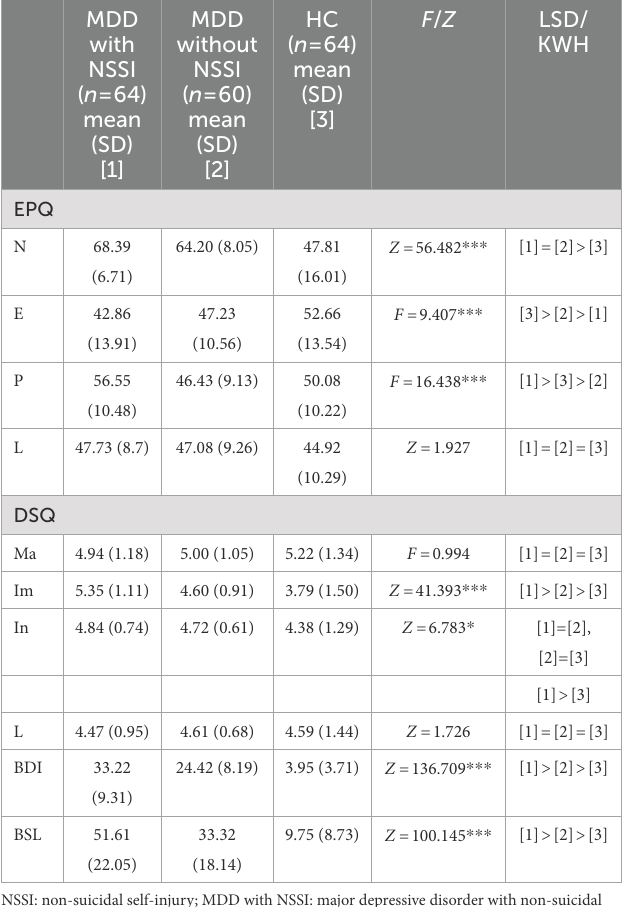
r p 0.117 0.359 − 0.023